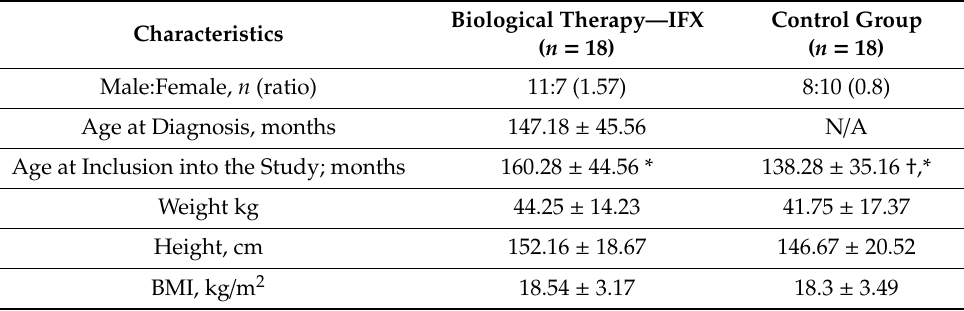
Table 1. Baseline characteristics of the study